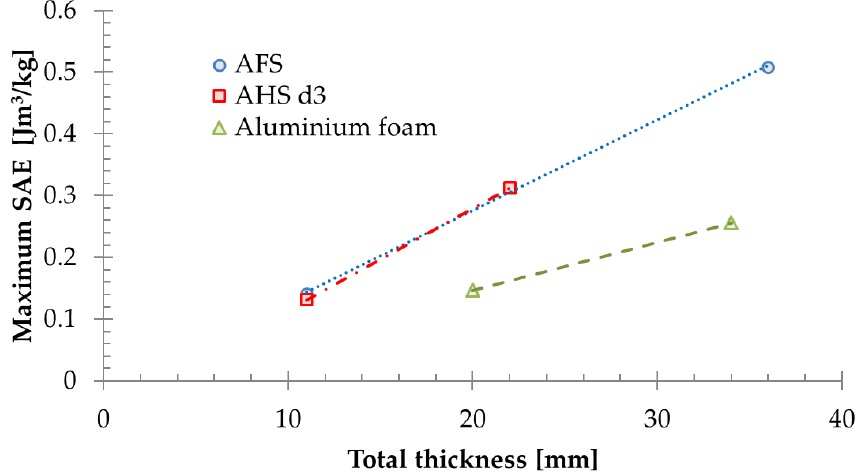
Figure 6. Maximum SAE versus total thickness.